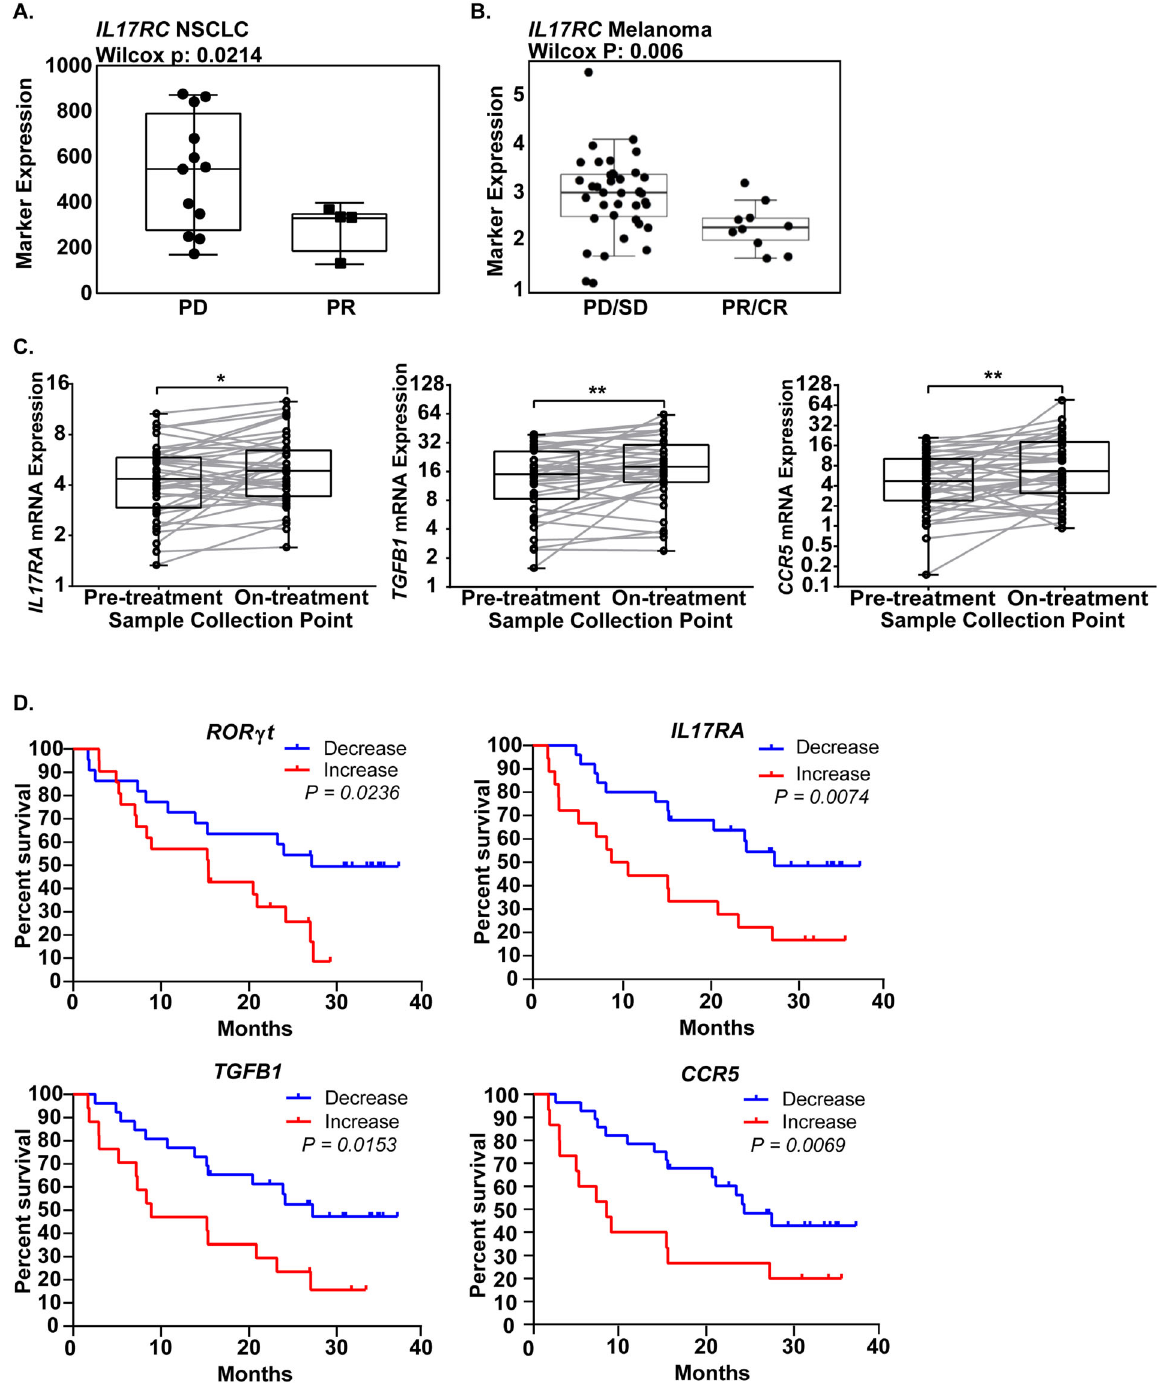
Fig. 5 Th17 gene signatures correlate with decrease in survival in IO-treated melanoma patients. A IL17RC mRNA levels in NSCLC patients that exhibited progressive disease (PD) versus partial response (PD) to anti-PD-1 therapy (nivolumab). 12 patients de fi ned as a progressive disease and four patients de fi ned as a partial response. Statistics calculated using two-sided Wilcoxon matched pair rank test with signi fi cance at P < 0.05. B Pre-treatment IL17RC mRNA levels in melanoma patients that exhibited progressive or stable disease (PD/SD) versus partial or complete response (PR/CR) to anti-PD-1 therapy (nivolumab). 36 patients de fi ned as PD/SD and 10 patients de fi ned as PR/CR. Statistics calculated using two-sided Wilcoxon matched pair rank test with signi fi cance at P < 0.05. C Left: IL17RA, middle: TGFb1, and right: CCR5 mRNA expression levels in melanoma patient samples in pre- and on- treatment of nivolumab. Statistical difference was determined using Wilcoxon matched pair rank test. 39 independent patient samples for pre-treatment and on-treatment. Boxplots are shown as the median ± 1 quartile, whiskers extend to an extreme data point. Statistics calculated using two-sided Wilcoxon matched pair rank test with signi fi cance at * P < 0.05, ** P < 0.01. D Kaplan – Meier curves predicting survival of nivolumab-treated melanoma patients based on net changes in ROR γ t, IL17RA, TGFB1, and CCR5. Percent survival decreases shown in blue and increase shown in red. Statistical difference was determined using the Log-rank Cox